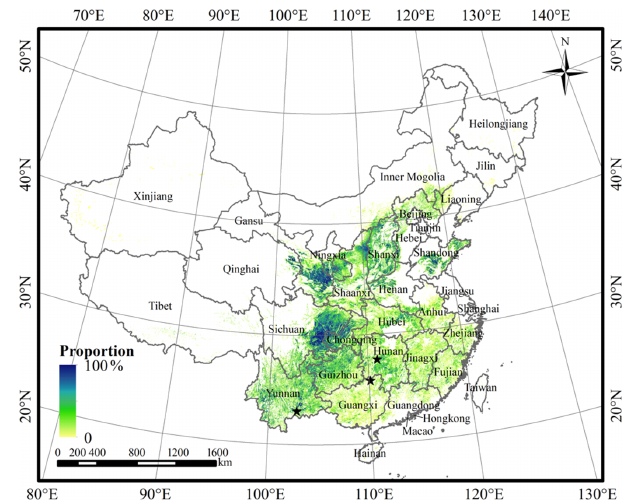
Figure 3. Terrace distribution across China in 2018. The map val- ues indicate the proportion of terraces within a 1km × 1km grid cell except for Heilongjiang, Liaoning, and Xinjiang, where the map- ping results are displayed at 5km × 5km resolution for clearer vi- sual effect. Shanghai and Macao are the only two provinces have no terraces on this map. The locations of three well-known terraces shown in Fig. 4 are marked as stars in the terrace map.